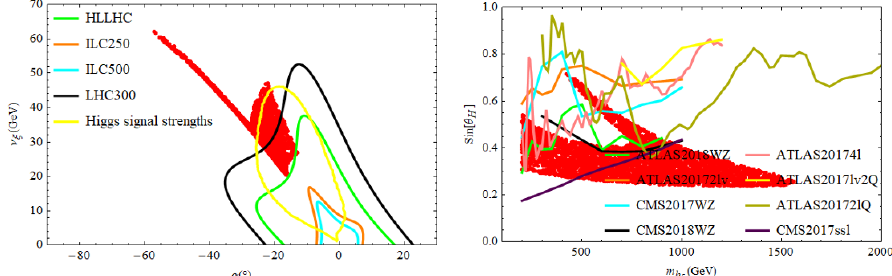
Figure 8 . Left:The v C =T C > 1 viable points in the plane of (cid:11) (cid:0) v (cid:24) for one-step phase transition; right: the v C =T C > 1 viable points in the plane of sin (cid:18) H (cid:0) m h